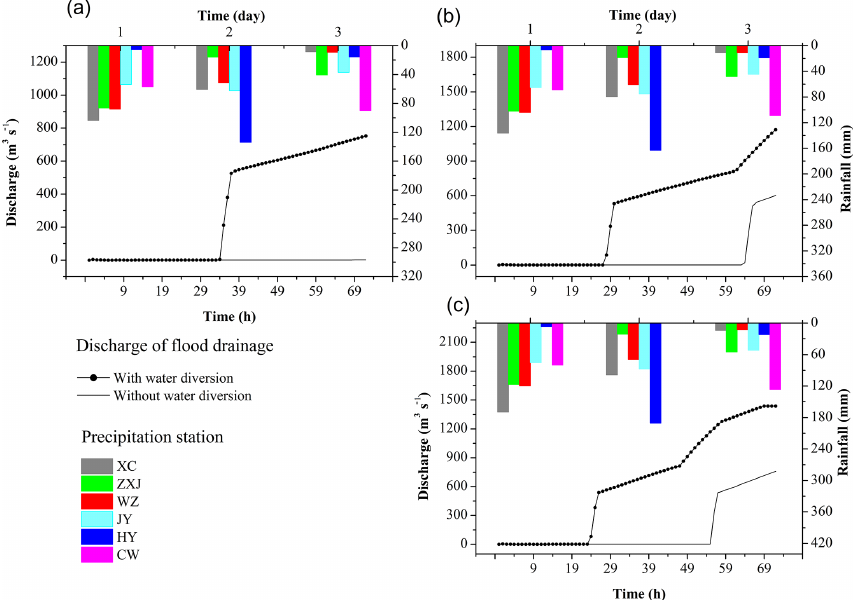
Figure 9. Changes in the flood discharge of the ED under water diversion with different storm levels. Flood discharge under rainfall events for different return periods: 5 years (a) , 10 years (b) , 20 years (c) . The bar chart with different colours shows the 3-day rainfall processes at each rainfall station. Black lines represent the flood-discharge process of the ED with and without the effect of water